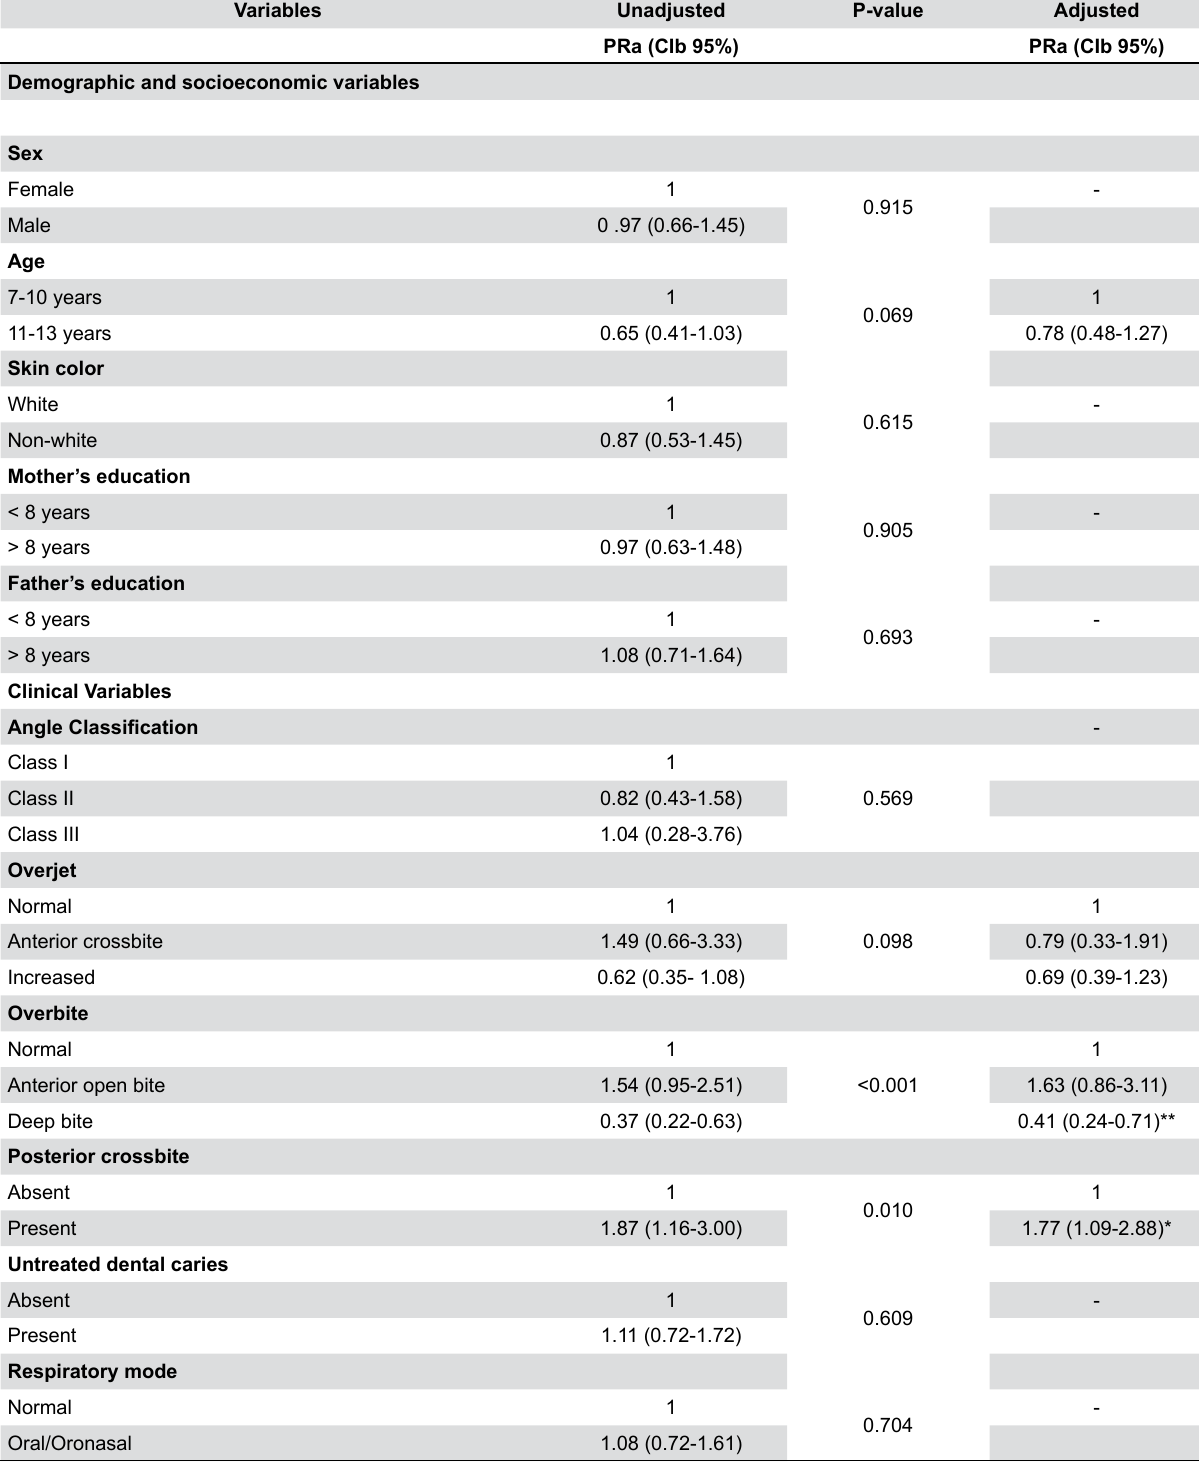
Table 4- Unadjusted and adjusted association between the independent variables for speech distortion, determined using Poisson regression with robust